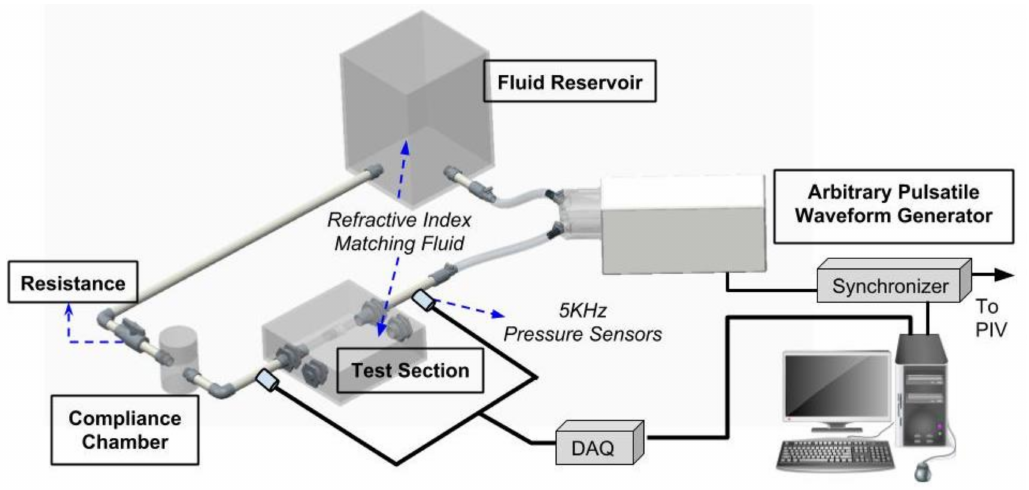
Figure 1. Schematic of the cardiovascular flow